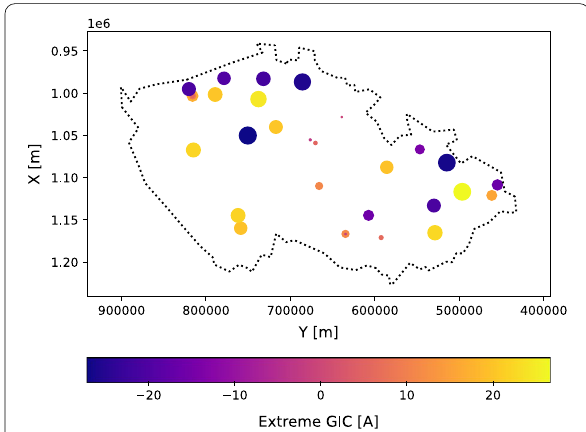
Fig. 7 Expected GICs in the studied substations with the 1-V/km northbound electric